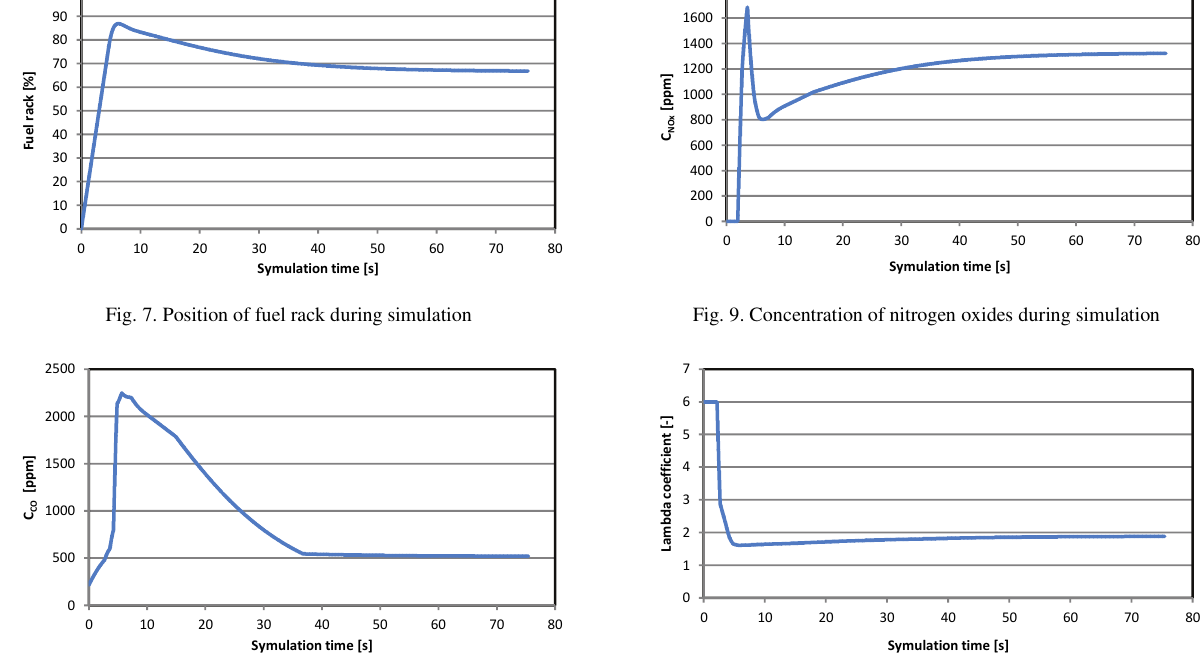
Fig. 8. Concentration of carbon monoxide during simulation